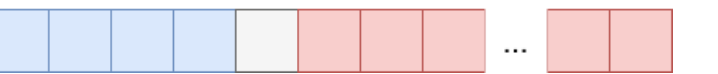
Figure 2. Three different scenarios considered concerning size of training set. Each square represent a chunk of 15-day data. Data are organized chronologically. Blue squares represent training data, grey squares represent data that are ignored (gap), and red squares represent testing